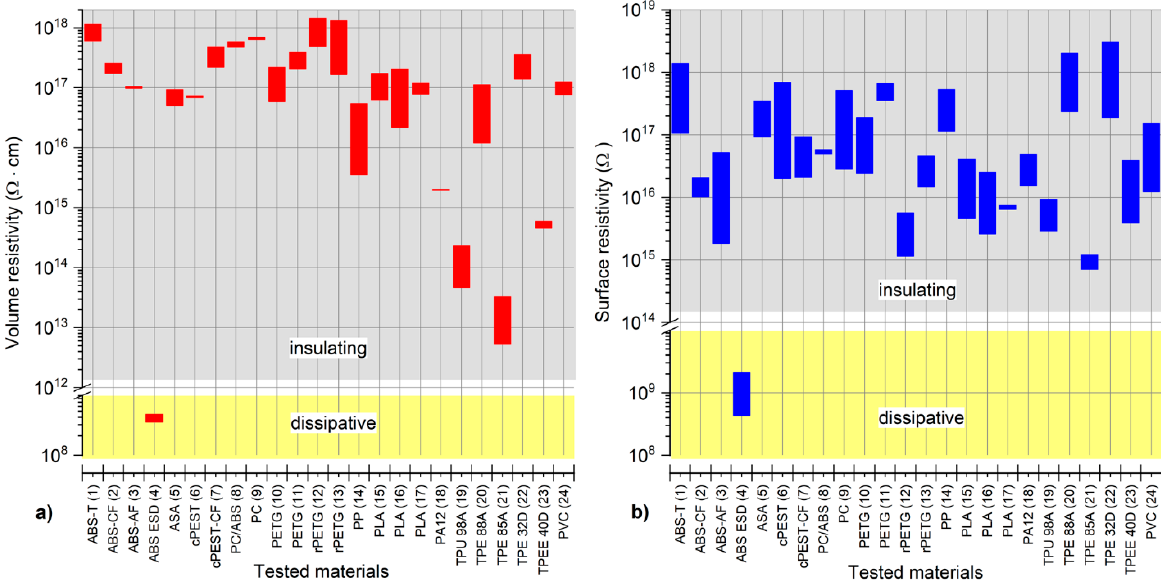
Figure 3. Graphical comparison of the ( a ) volume and ( b ) surface resistivity value ranges for all tested materials.